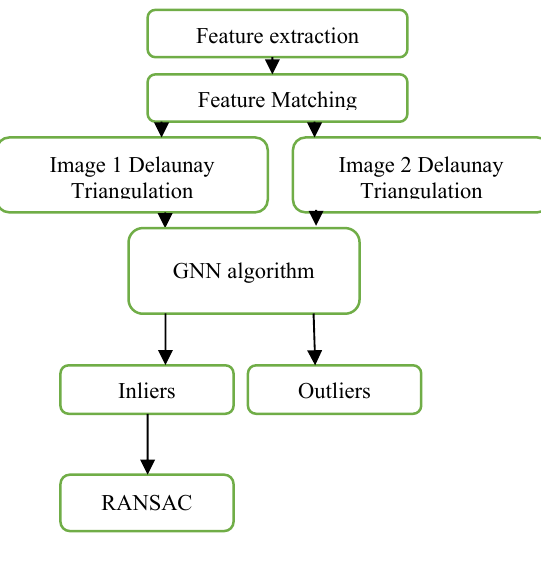
Figure 9 : The 2nd proposed algorithm graph neural network RANSAC (GNN_RANSAC)